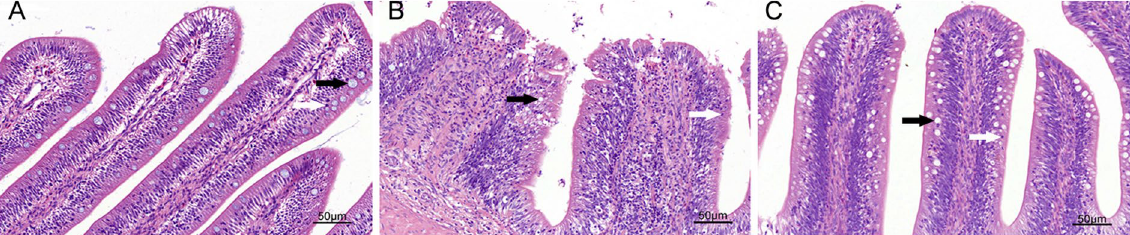
Figure 3. Histological changes of the intestines 48 h after oral application of A. hydrophila . ( A ) control (PBS) group, ( B ) A. hydrophila group, ( C ) B. subtilis + A. hydrophila group. In each panel, white arrows indicate goblet cells; black arrows indicate inflammatory cells.